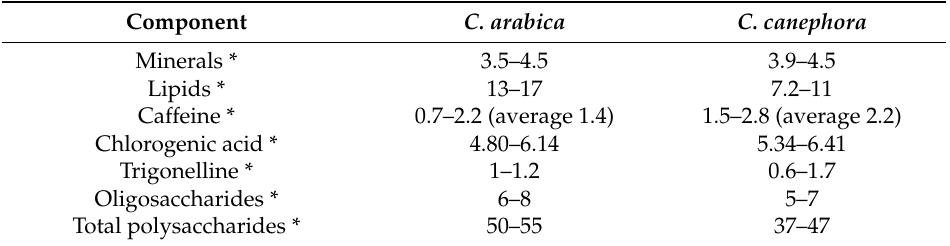
Table 2. Comparison of chemical components of green beans in Coffea arabica and Coffea canephora